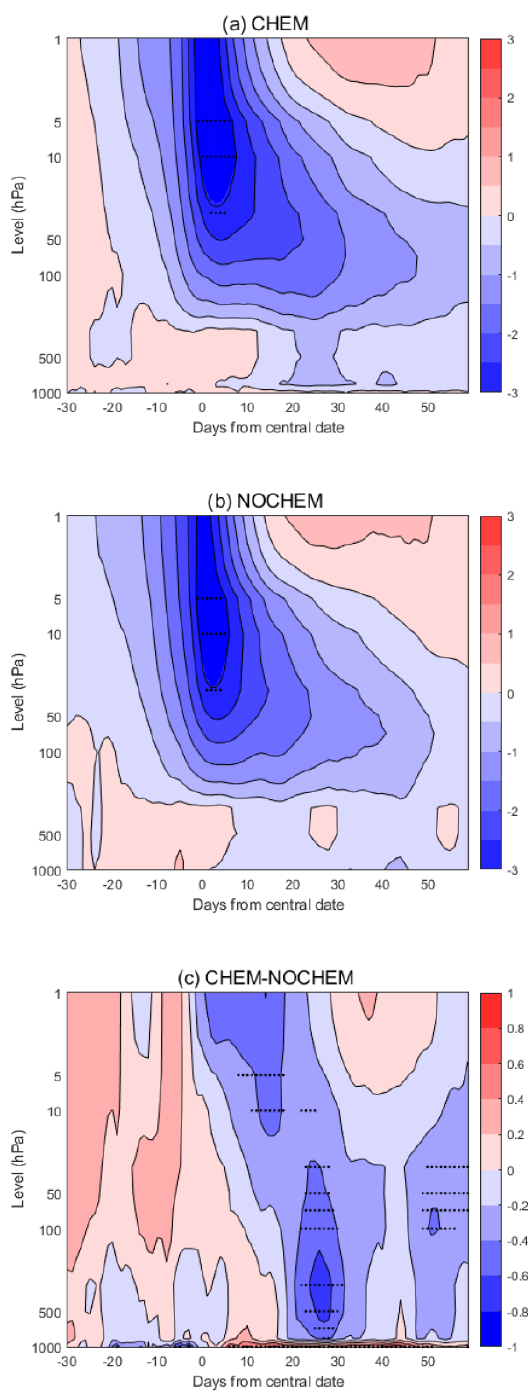
Figure 4. NAM anomaly composites around DJF SSW central dates in CHEM (a) , NOCHEM (b) , and CHEM-NOCHEM (c) . Stip- pling shows significance at the 95% level (with a Monte Carlo test for CHEM and NOCHEM and a two-tailed t test for CHEM- NOCHEM). Contours are every 0.5 standard units for CHEM and NOCHEM and every 0.2 standard units for